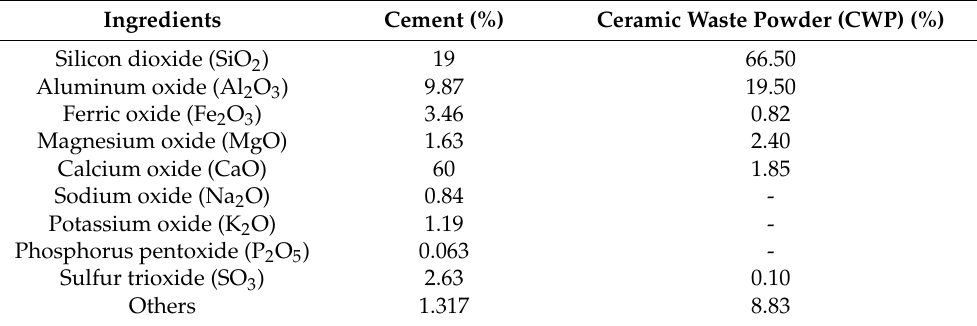
Table 1. Chemical compositions of cement and CWP (all presented values in %).